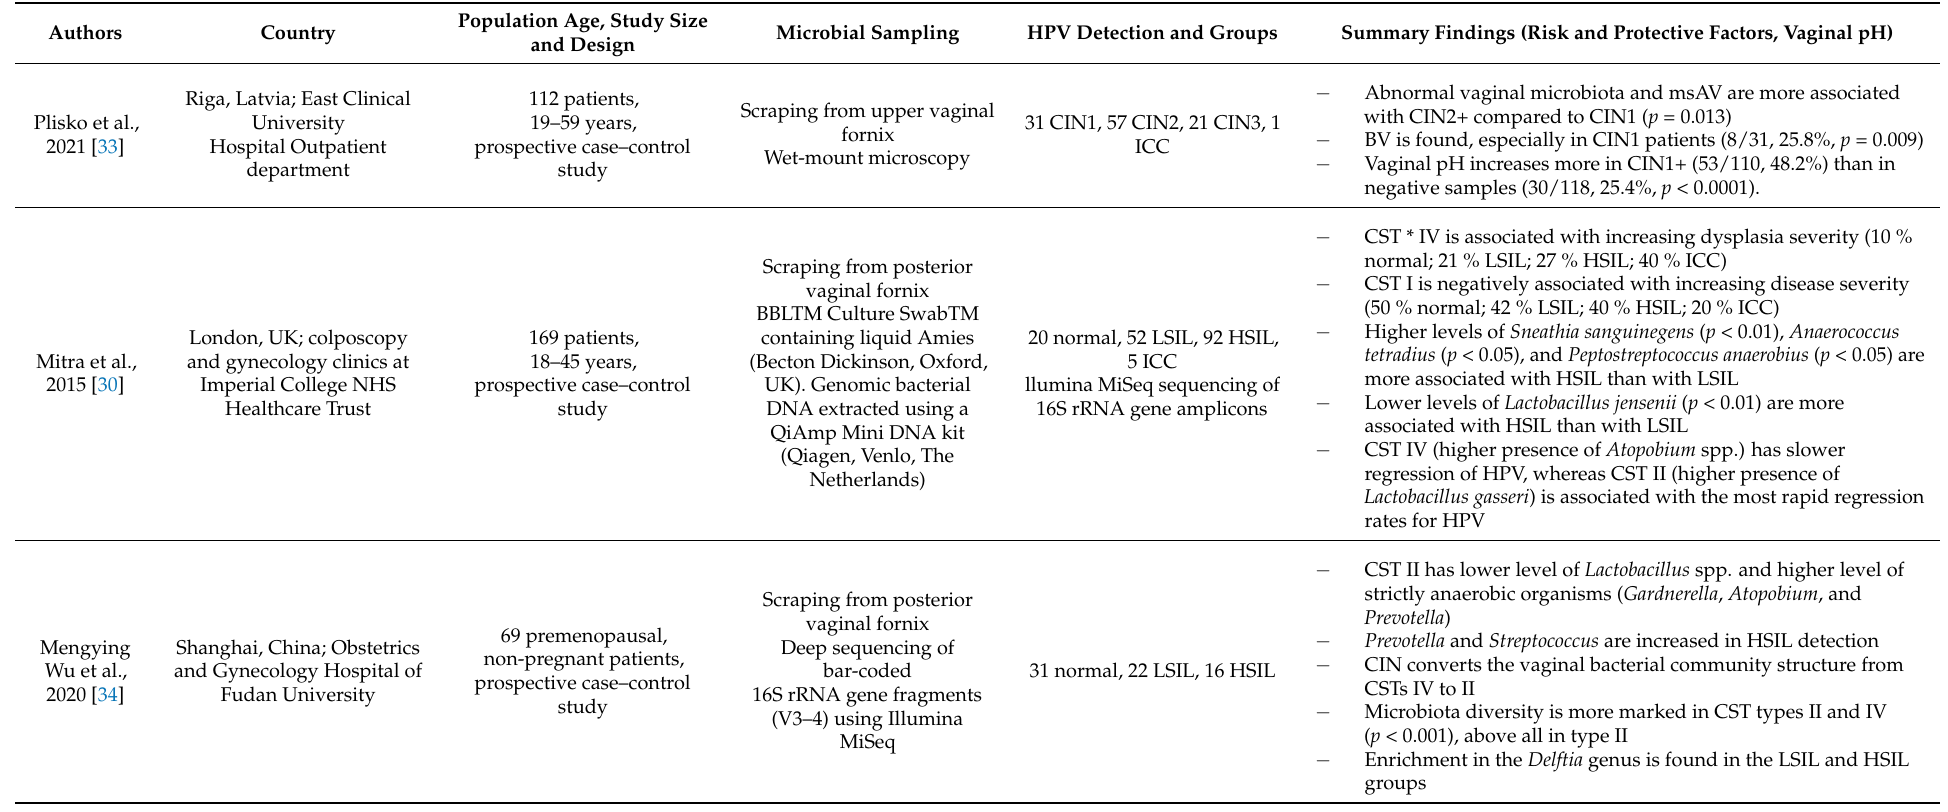
Table 1. Characteristics of studies exploring the association of HPV infection and cervical preinvasive disease to the vaginal